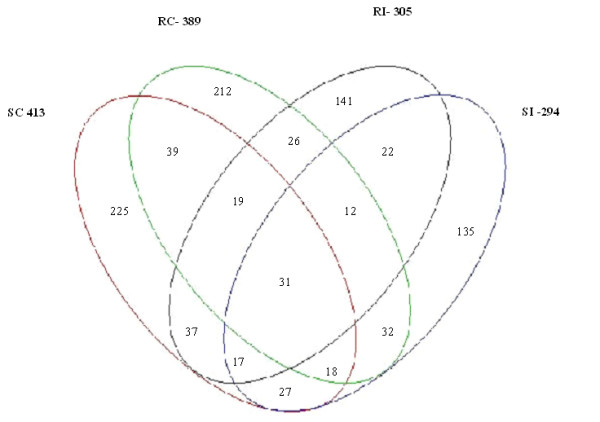
Co-expression pattern of the ESTs. The 12 SSH libraries were grouped into four classes: resistant infected (RI)-libraries 1, 2 and 9; resistant control (RC)-libraries 4, 5 and 11; susceptible infected (SI)- 3, 7 and 12; and susceptible control (SC)- 6, 8 and 10 libraries. The distribution of the ESTs that were used to generate the 993 non-redundant contigs was plotted among the four classes.